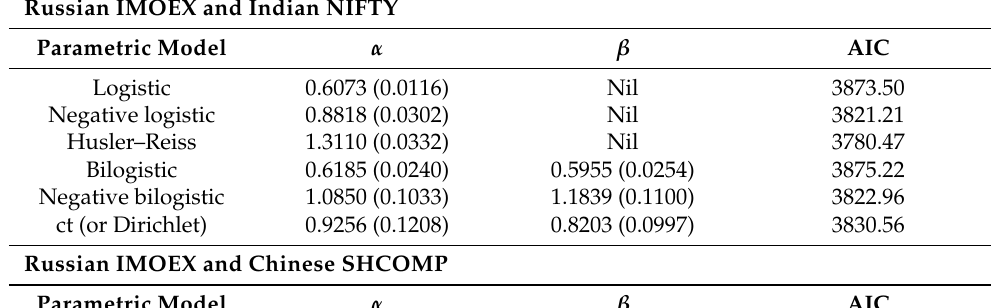
Table 6. Estimates of the point process dependence modelling.